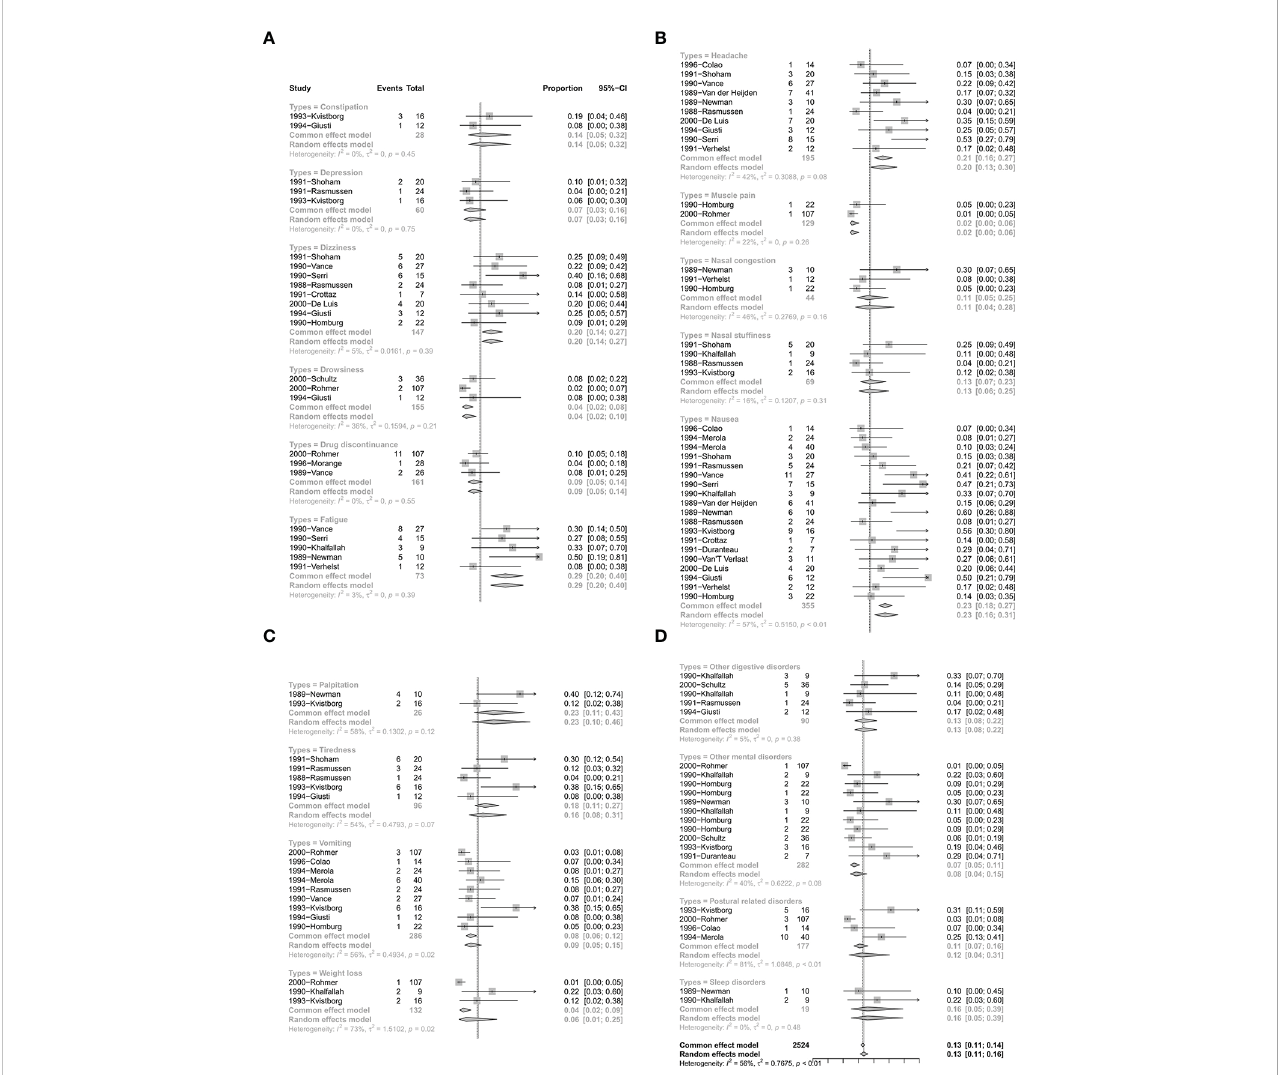
FIGURE 5 The safety of quinagolide treatment. (A) The pooled proportion of constipation, depression, dizziness, drowsiness, drug discontinuance, fatigue; (B) The pooled proportion of headache, muscle pain, nasal congestion, nasal stuf fi ness, nausea; (C) The pooled proportion of palpitation, tiredness, vomiting, weight loss; (D) The pooled proportion of other digestive disorders, other mental disorders, postural disorders, sleep